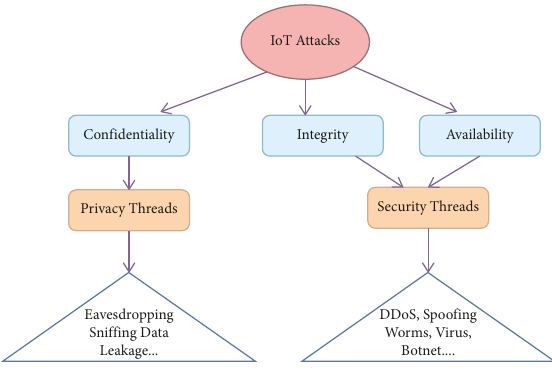
Figure 1: Privacy and security of IoT